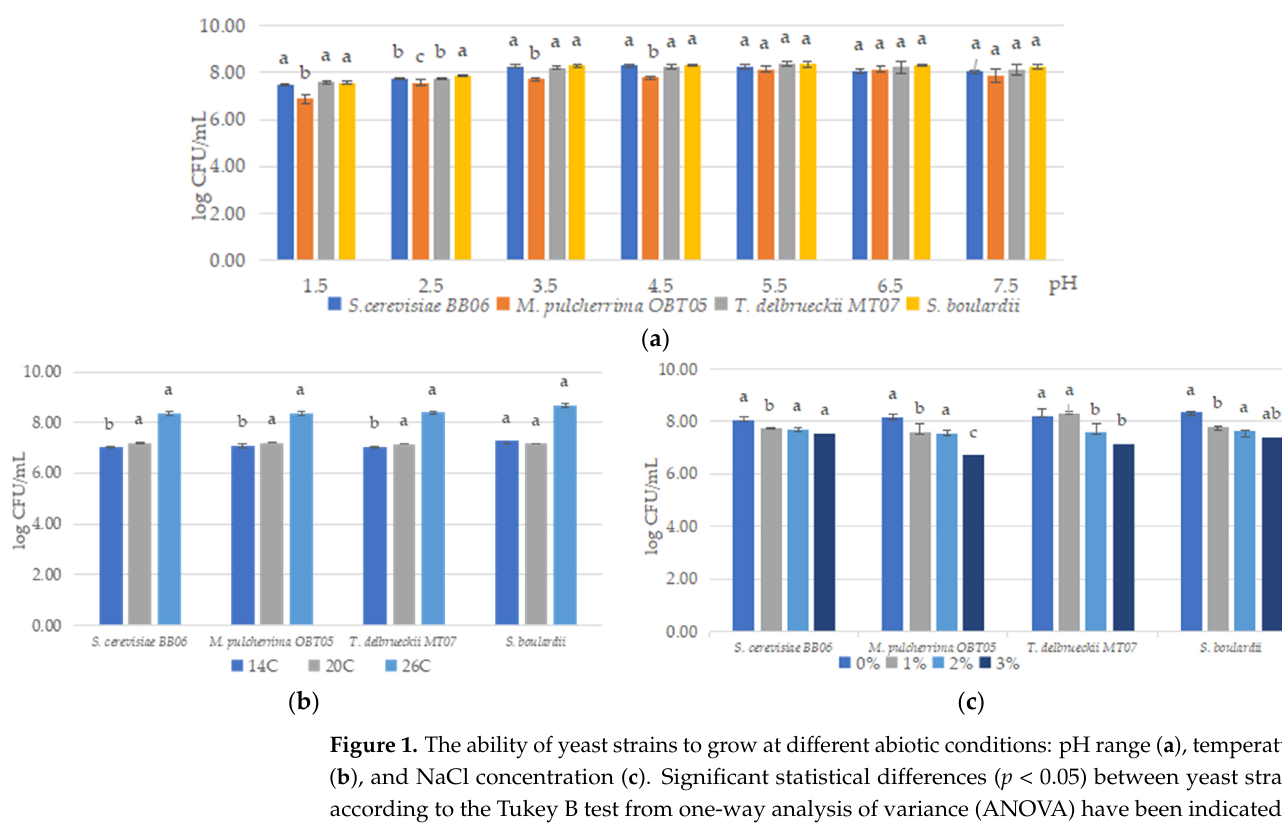
Figure 1. The ability of yeast strains to grow at different abiotic conditions: pH range ( a ), temperature ( b ), and NaCl concentration ( c ). Significant statistical differences ( p < 0.05) between yeast strains according to the Tukey B test from one-way analysis of variance (ANOVA) have been indicated by different letters. Table 1. Summarized characteristics and properties of yeast strains: auto-aggregation ability, hy- drophobicity, and antioxidant activity.